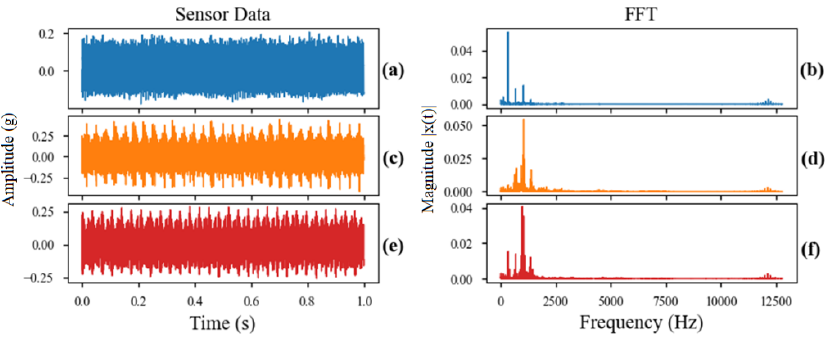
Figure 9. Sensor C signals. ( a ) Healthy, ( b ) Healthy FFT, ( c ) Fault-1 ( d ) Fault-1 FFT, ( e ) Fault-2, ( f ) Fault-2 FFT.